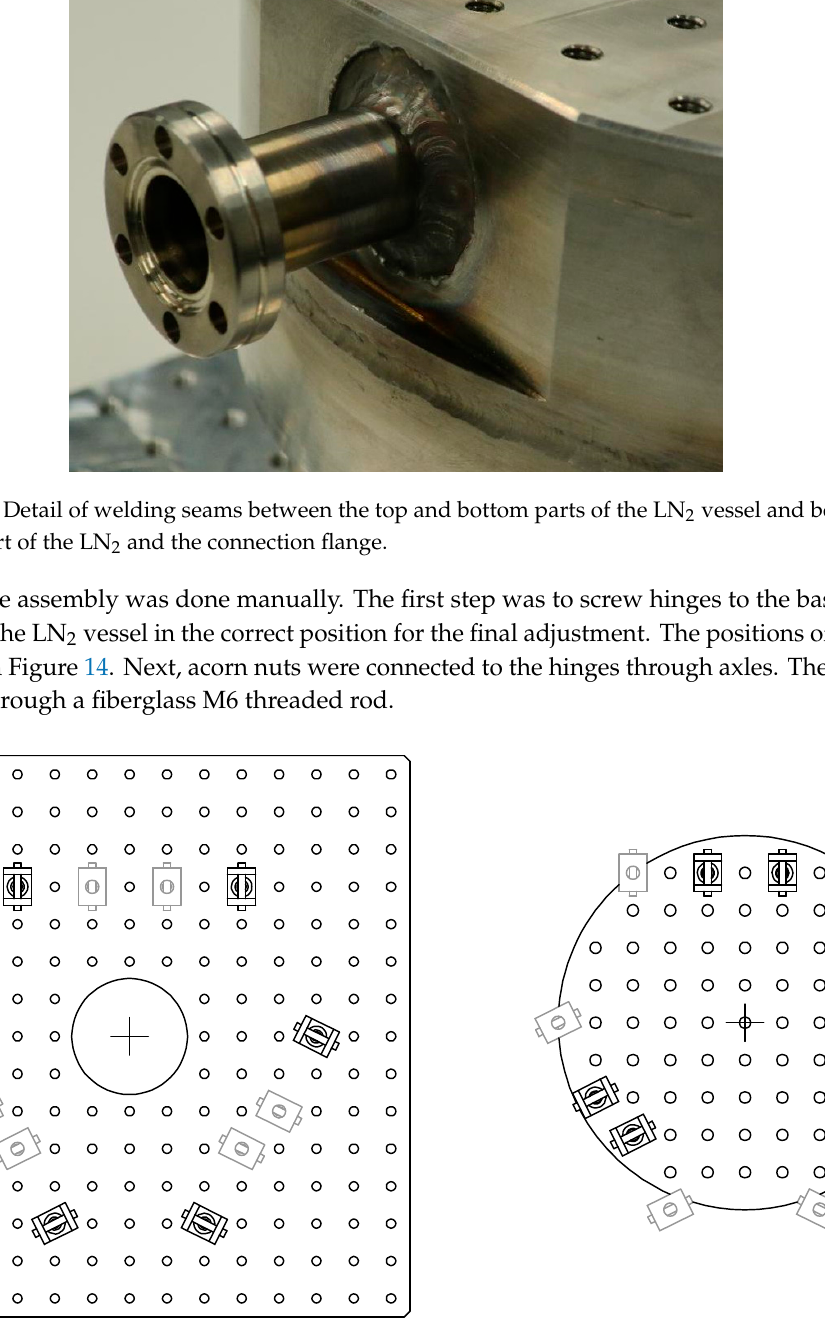
Figure 14. Positions of the hinges in the baseplate ( left ) and the bottom of the LN 2 vessel ( right ).